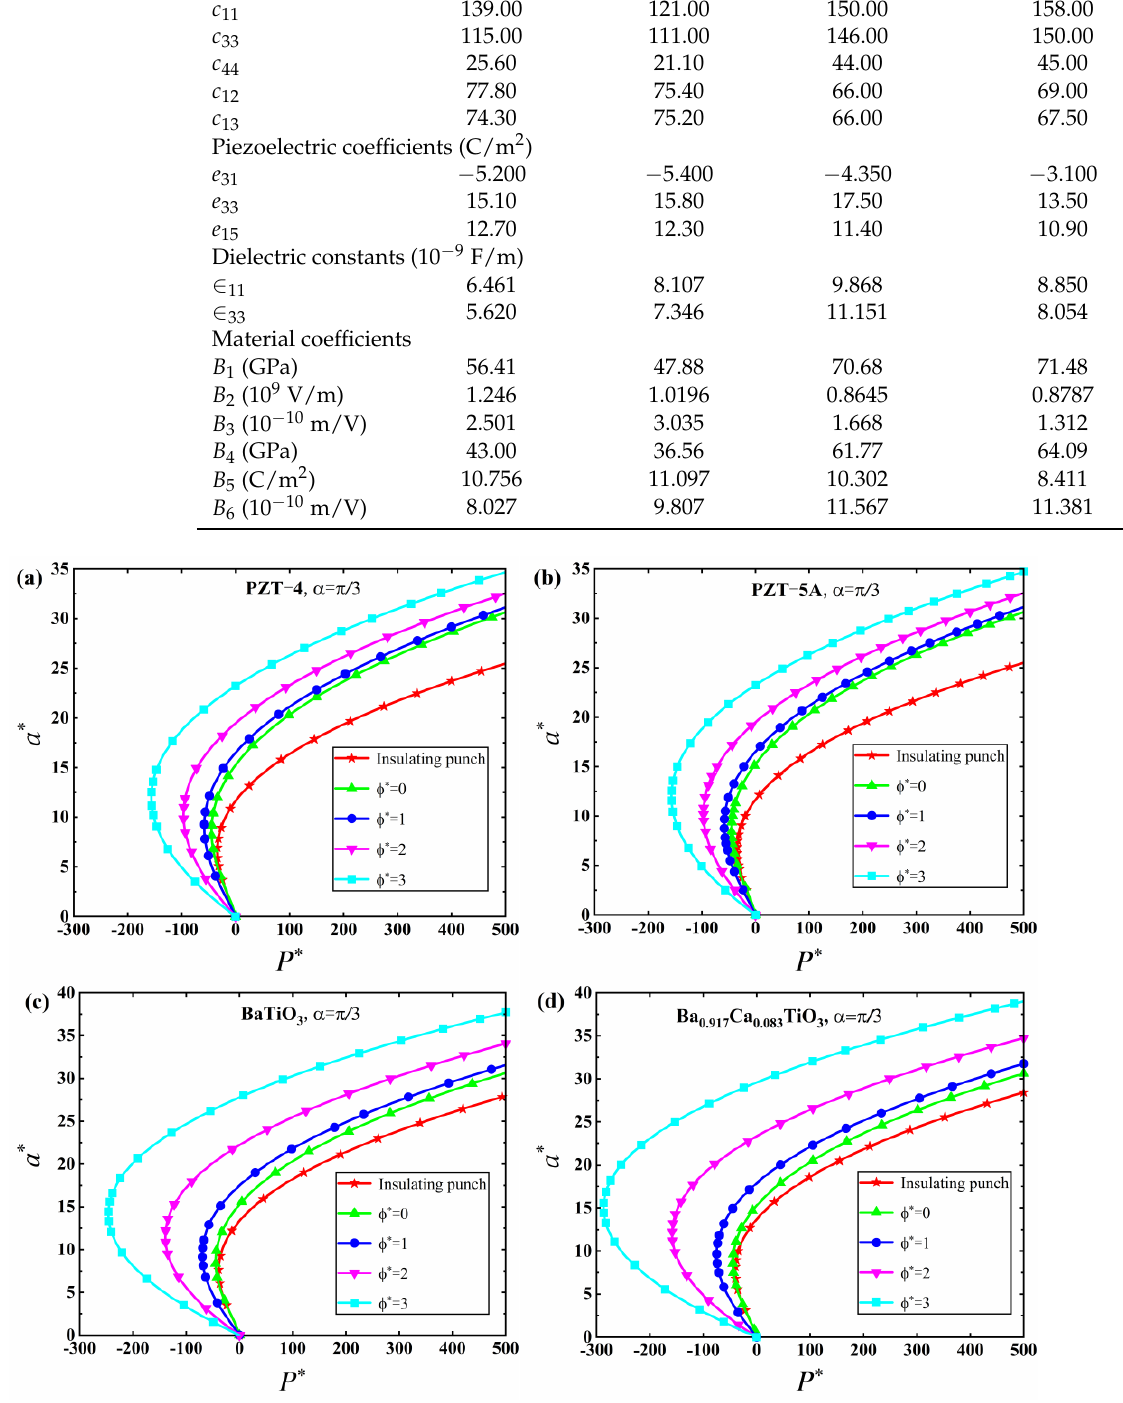
Figure 3. The dimensionless contact radius, a ∗ , as a function of the dimensionless indentation force, P ∗ , at a fixed value of α = π /3 for the JKR model. ( a ) PZT-4. ( b ) PZT-5A. ( c ) BaTiO 3 . ( d ) Ba 0.917 Ca 0.083 TiO 3 .